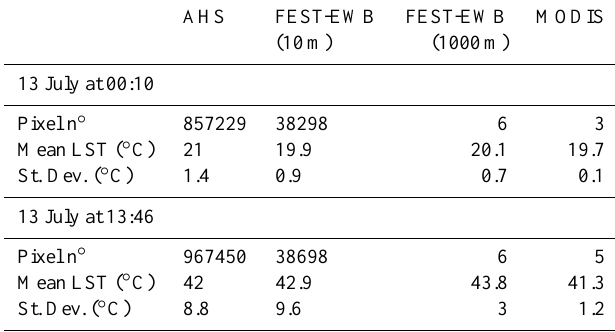
Table 4. Mean and standard deviation for the comparison between LST from MODIS, AHS and FEST-EWB.